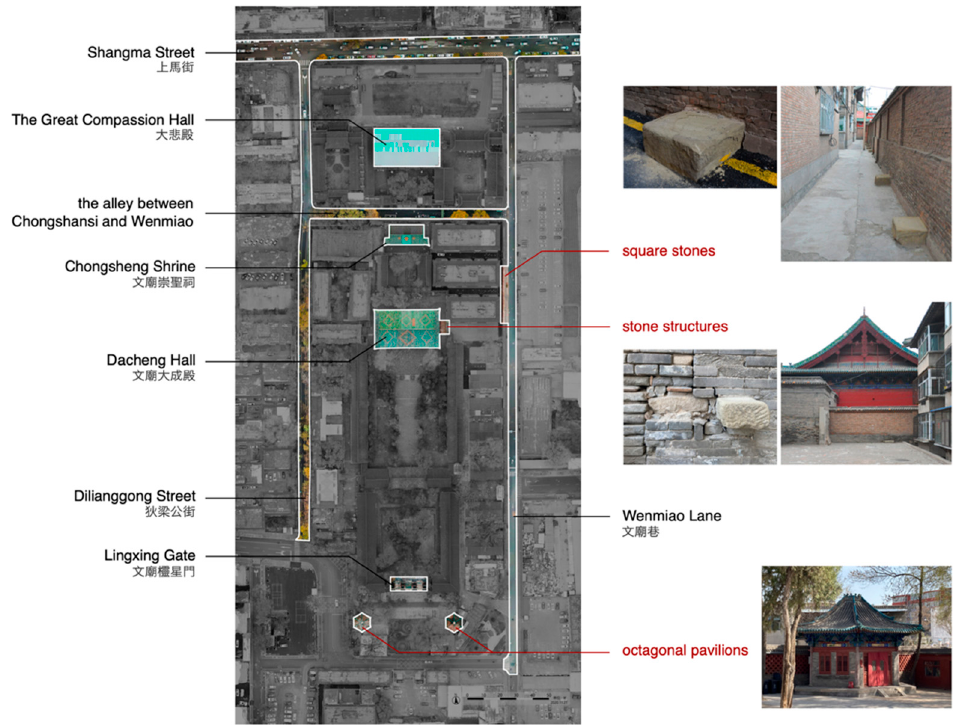
Figure 9. Traces of the Main Hall Complex left in the Chongshansi Community (aerial photo by